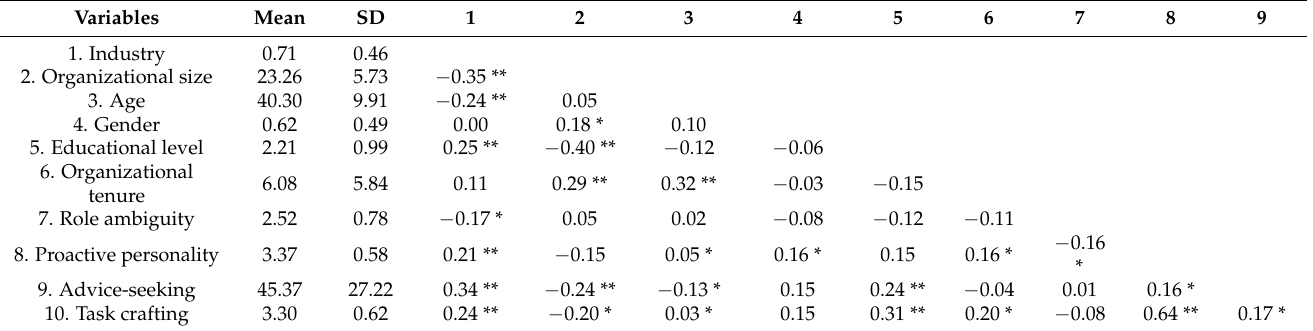
Table 1. Means, standard deviations, and correlations.